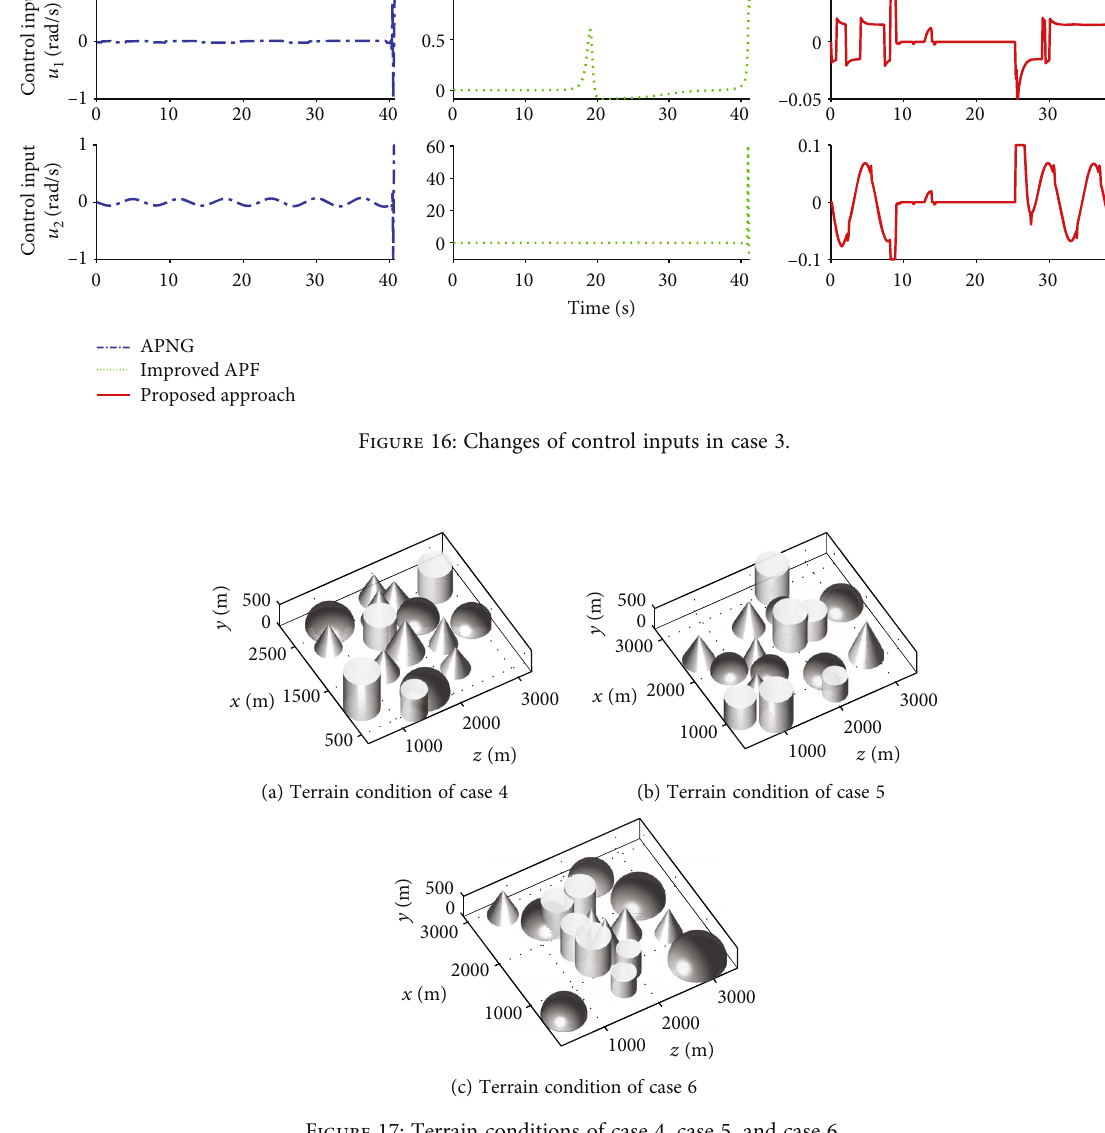
Figure 17: Terrain conditions of case 4, case 5, and case